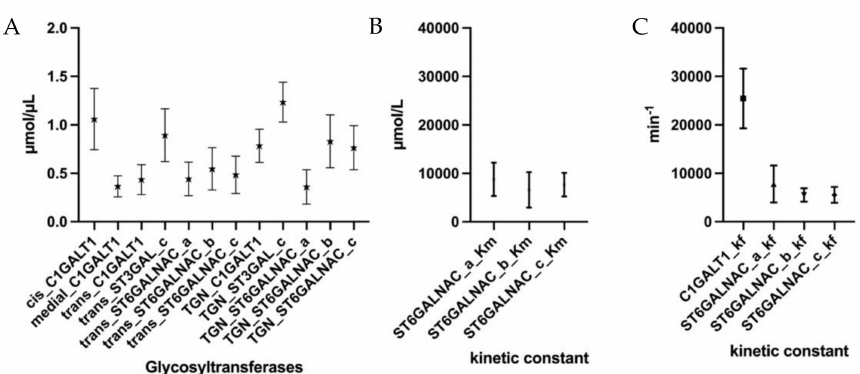
Figure 5. The 20 sets of parameters estimated for the CHO-WT model. ( A ) Estimated concentrations of the C1GALT1, ST3GAL, and ST6GALNAC in each compartment of Golgi. ( B ) Mean estimated K m values for ST6GALNAC. _a/b/c represents the three reactions catalyzed by the enzymes. ( C ) Mean estimated K f values for C1GALT1 and three reactions catalyzed by ST6GALNAC. Values are reported as mean with